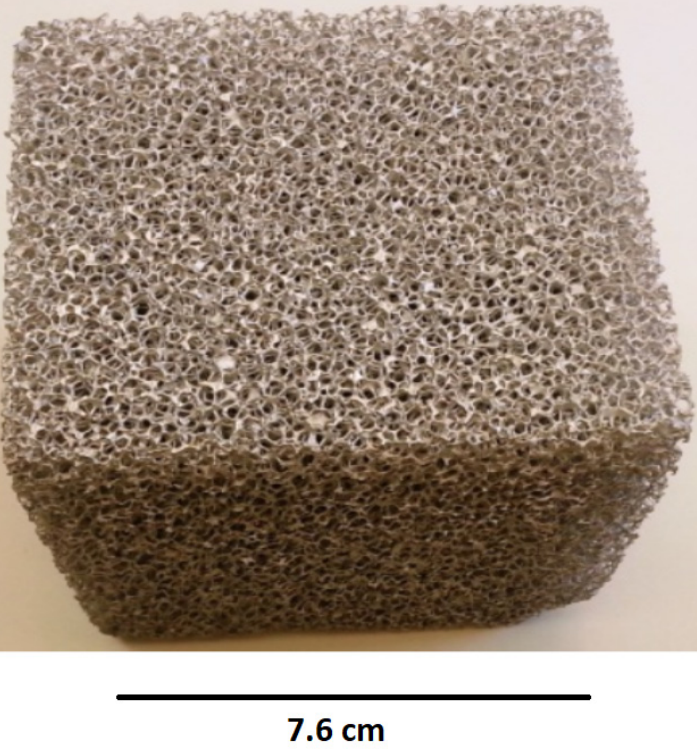
Figure 1. Photograph of a block of open-cell aluminum foam with 20 pores per inch. (Photo taken by author).